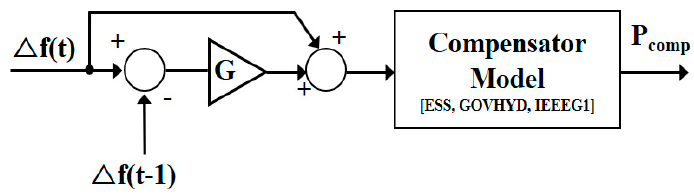
Figure 22. Improved method by Primary Frequency Regulation.